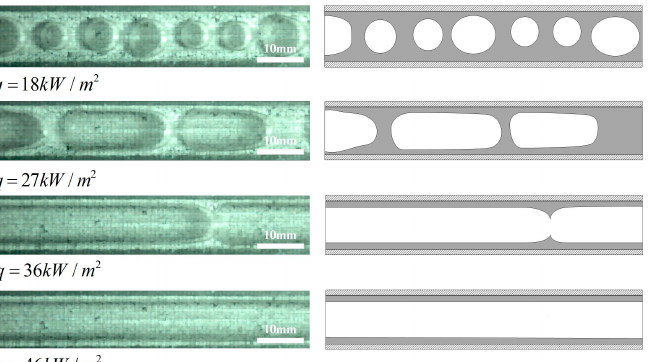
Figure 6. Two phase flow patterns of super-hydrophilic microchannel under different heat fluxes for G = 1265 kg/(m 2 s), x in = 0.066.